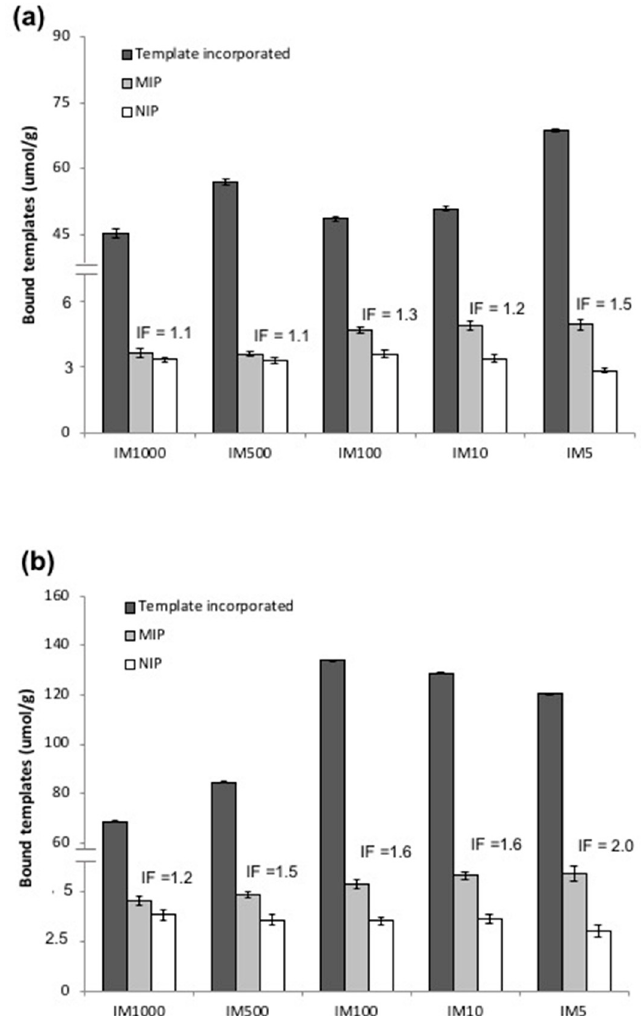
Figure 6. Comparison of the amount of ( a ) CAF and ( b ) THP incorporated and rebound by the MIP and NIP polymers synthesized at various I:tM ratios. Polymers were incubated for 18 h in 100 µM template rebinding solution and the post rebinding solutions were analyzed by HPLC.